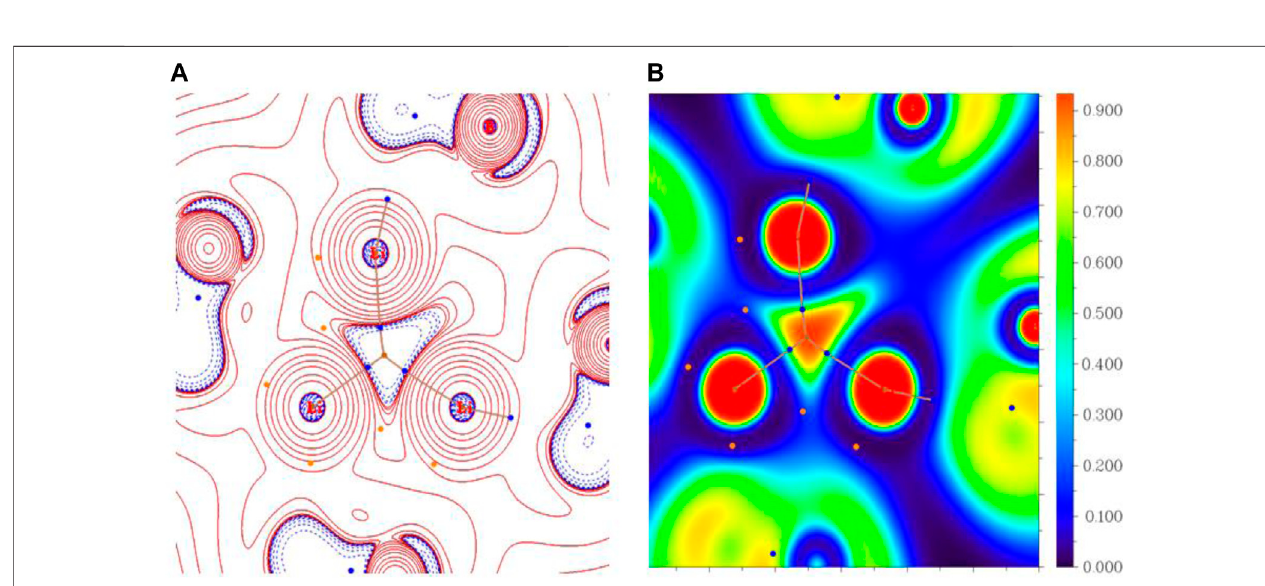
FIGURE 8 | The plots of (A) the Laplacian of electron density [ ∇ 2 ρ ( r )], blue dashed and red solid lines indicate ∇ 2 ρ ( r ) < 0 and ∇ 2 ρ ( r ) > 0 regions, respectively; (B) the electron localization function (ELF) basin of Li 3 @B 40 and Li 3 @C 60